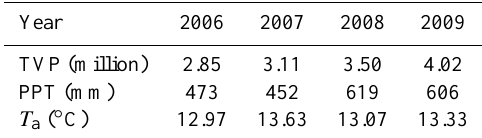
Table 2. Total vehicle population (TVP), annual precipitation (PPT), and annual average air temperature ( T a ) from 2006 to 2009. TVP data were derived from Wu et al. (2011). PPT and T a data were collected from Caoyang weather